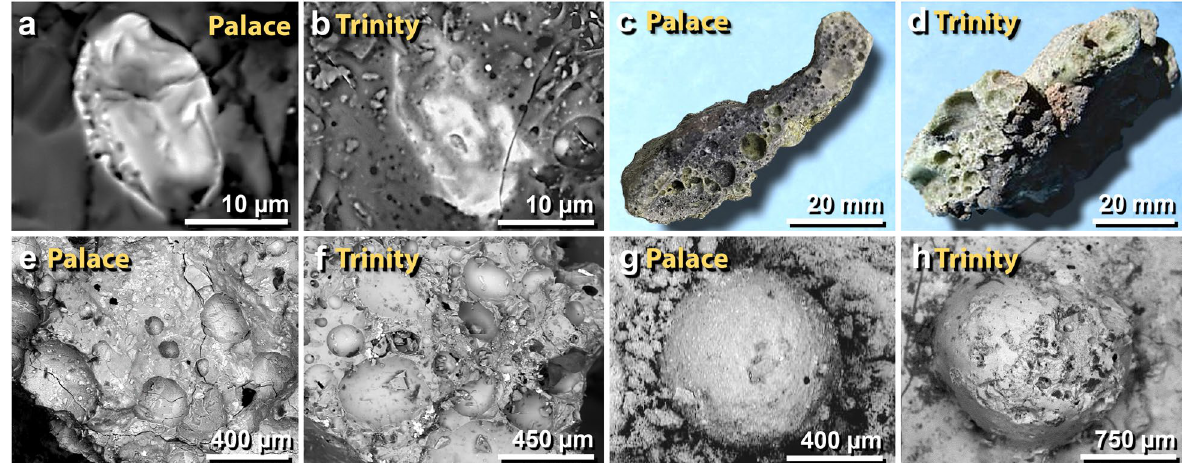
Figure 51. Comparison of melted materials from TeH with those from the Trinity atomic bomb test. ( a ), ( b ) SEM images compare a melted, decorated zircon embedded in mudbrick meltglass from the palace with similar material from Trinity. ( c ), ( d ) Photomicrographs compare a melted potsherd from the palace with similar- looking material from Trinity. ( e ), ( f ) The melted zircons in panels ‘ a ’ and ‘ b ’ were found in highly vesicular glass like these from the palace and the Trinity site, respectively. ( g ), ( h ) SEM images of a spherule fused onto mudbrick meltglass from the palace and a spherule embedded into trinitite from the Trinity atomic